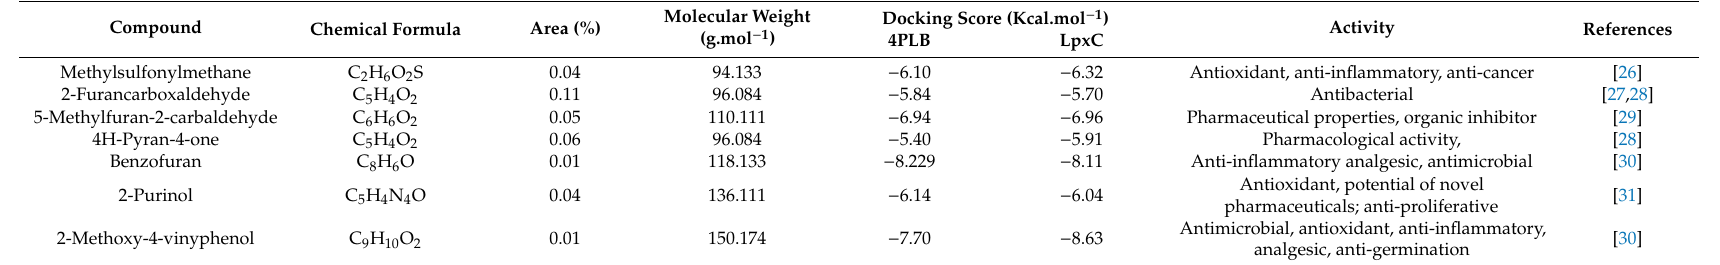
Table 3. Docking results of identified compounds from RCC